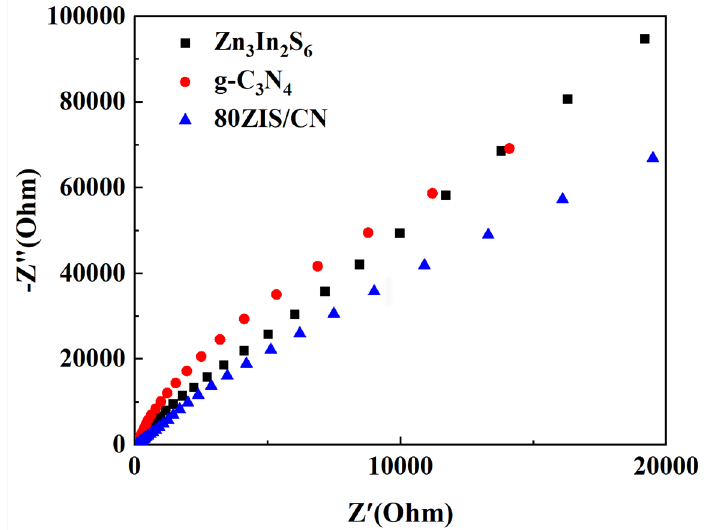
7 of 19 Figure 5. PL spectra: g ‐ C 3 N 4 , Zn 3 In 2 S 6 and 80ZIS/CN heterojunction.